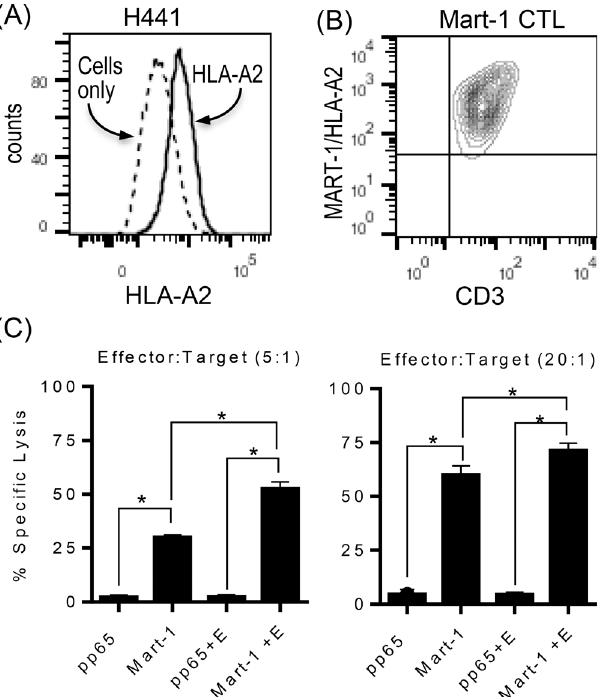
Fig 5. EGFR inhibitor increases antigen specific T cell mediated tumor killing. (A) The expression of HLA-A2 on HLA-A2 + lung cancer cell line, H441, was confirmed using flowcytometry. (B) Mart-1 (M27) specific cytotoxic T cell line (CTL), 1007G, was stained with anti-CD3 and Mart-1 (M27)/HLA-A2 tetramer to confirm the antigenic specificity. More than 90% of T cells expressed T cell receptors specific for